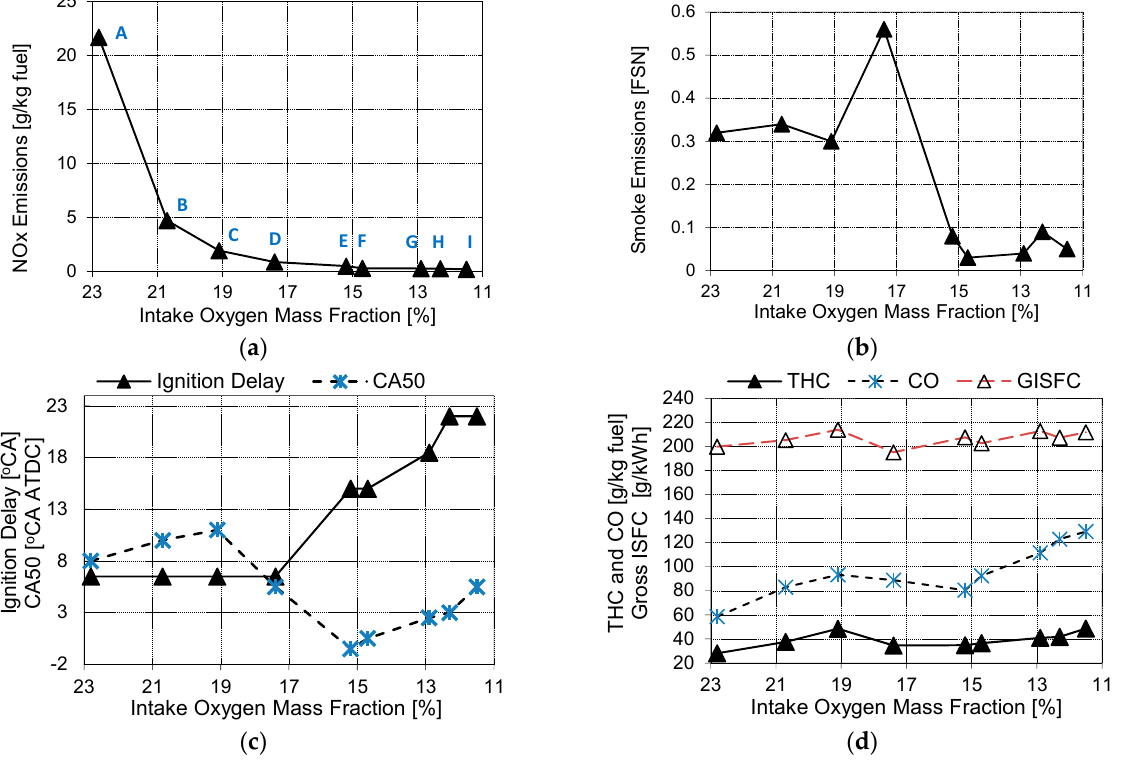
Figure 2. ( a ) NOx, ( b ) smoke, ( c ) ignition delay, CA50 and GISFC, and ( d ) THC and CO emissions, during the EGR sweep. Data point references in ( a ) indicate the corresponding case from Table 2.